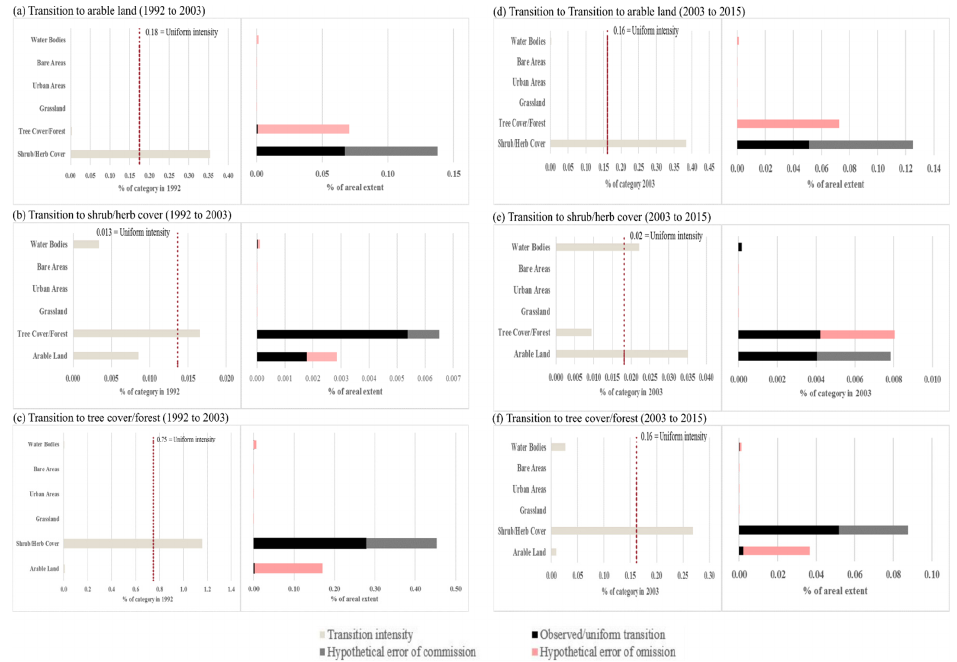
Figure 4. ( a – f ) Intensity Analysis for transition-level changes for each land-cover category for gaining categories during two time intervals for the study area, showing the observed transition intensities for each gaining category (left figures), and the percentage of area that changed category over the interval (right figure).